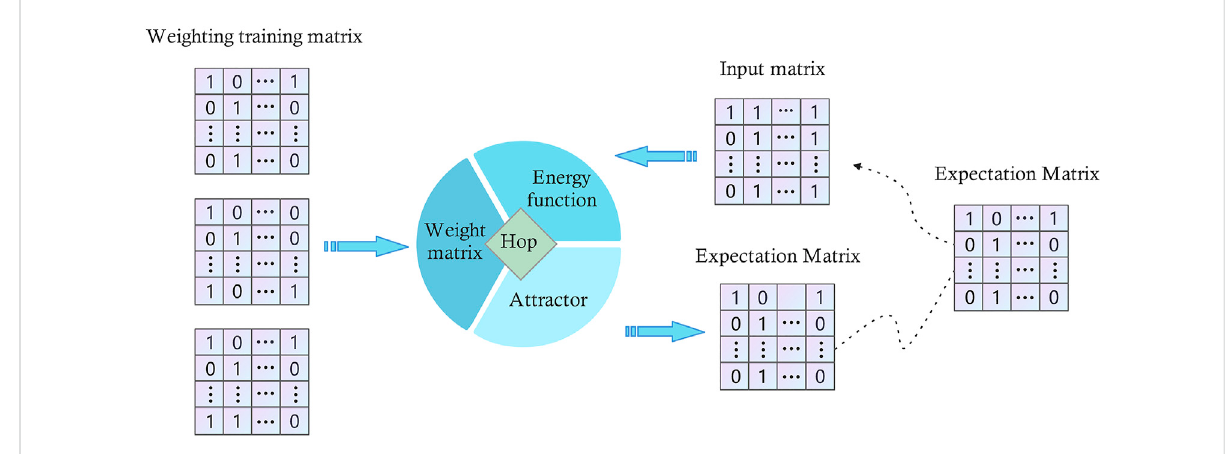
FIGURE 7 Example model of fragmented data recovery.